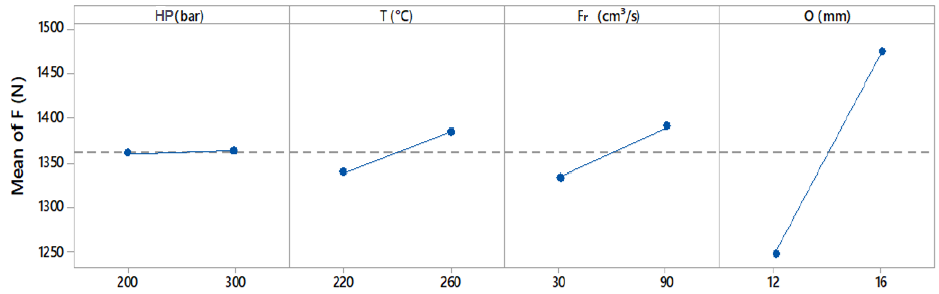
Figure 6. Main factors contributing to strength (N), taking into account the overlaps of 12 and 16 mm.